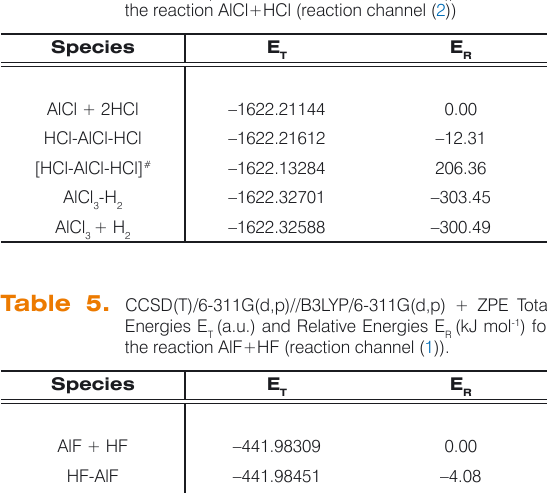
Table 4. CCSD(T)/6-311G(d,p)//B3LYP/6-311G(d,p) + ZPE Total Energies E (a.u.) and Relative Energies E T